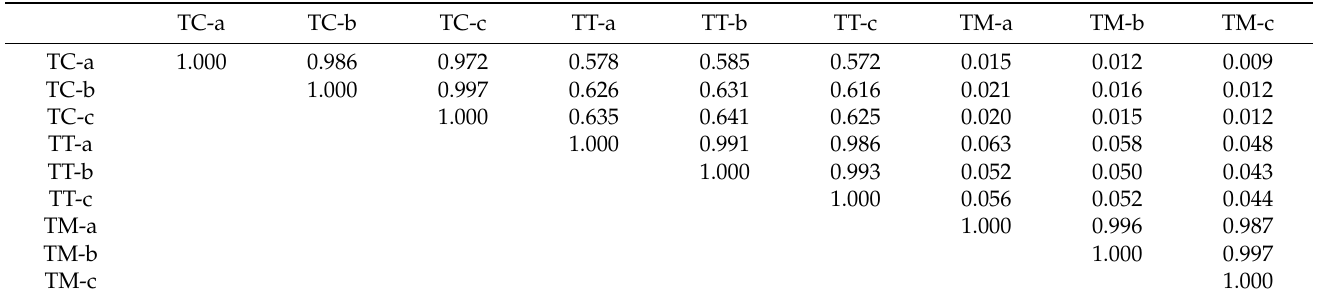
Table 4. Aroma similarity rates between the three species of Tilia at different flowering